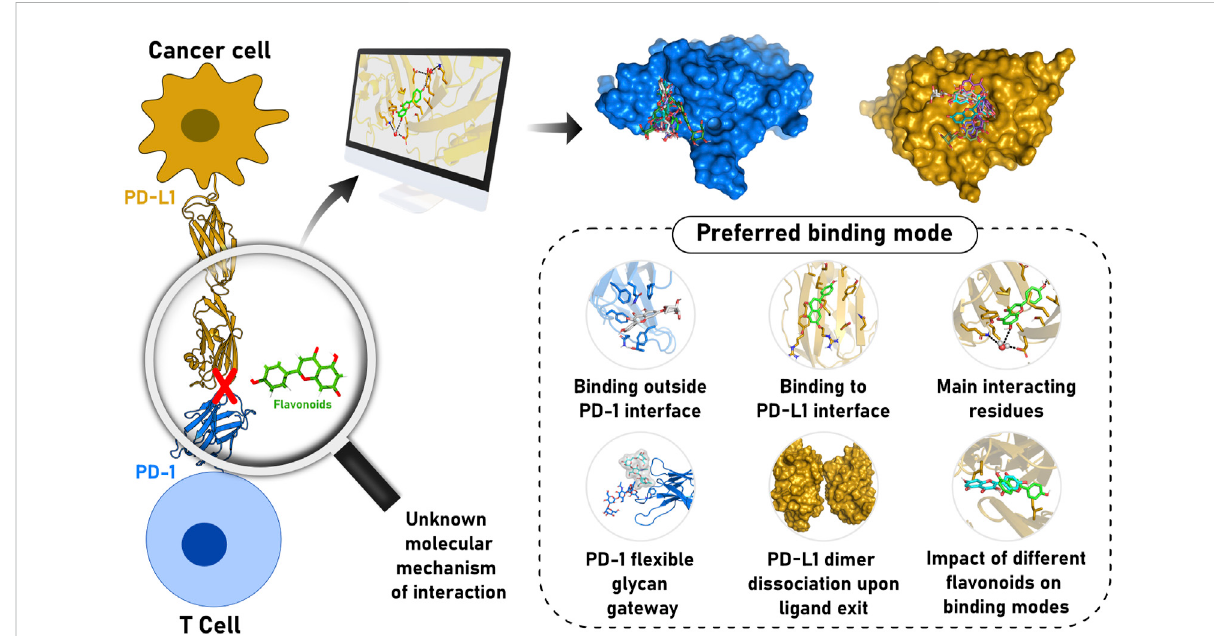
FIGURE 1 Schematic representation of fl avonoid relevance to cancer treatment through PD-1/PD-L1 axis modulation and our major fi ndings regarding the structural and dynamics determinants for molecule recognition. Flavonoids can inhibit the PD-1/PD-L1 complex, allowing lymphocytes to recognizecancercellsandpromotecontrolledcelldeath.However,themodeofinteractionofthemoleculeswithPD-1and/orPD-L1remainstobe understood. In this context, computational methods were applied to propose an accurate model representing the binding mode of different fl avonoid derivatives. We suggested fl avonoids could interact with PD-1 in a transiently occluded pocket outside the GFCC ’ strands interface. Furthermore,wedescribedhowthe fl avonoidmodi fi cations in fl uence theinteractionwith themainresidues ofthePD-L1 dimerinterface cavity and the effect on the molecule